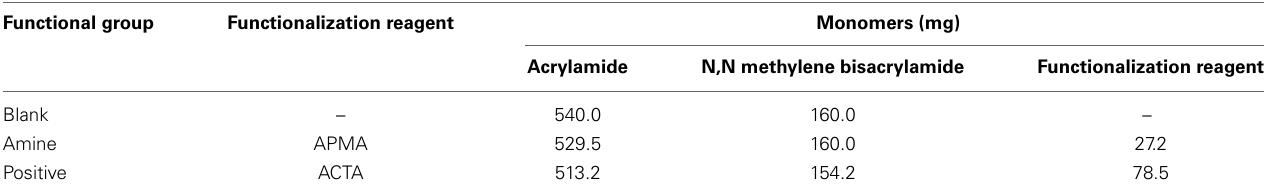
Table 2 | Quantities of monomers required to synthesize blank, amine-functionalized, and positively charged nanosensors. Functional